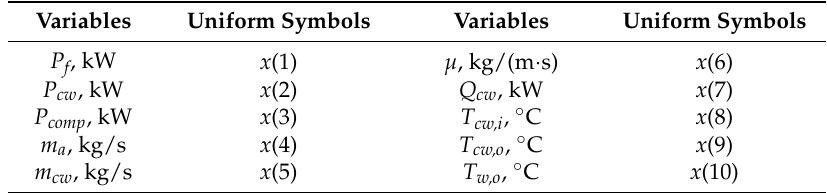
Table 1. Ten unknown variables and their uniform